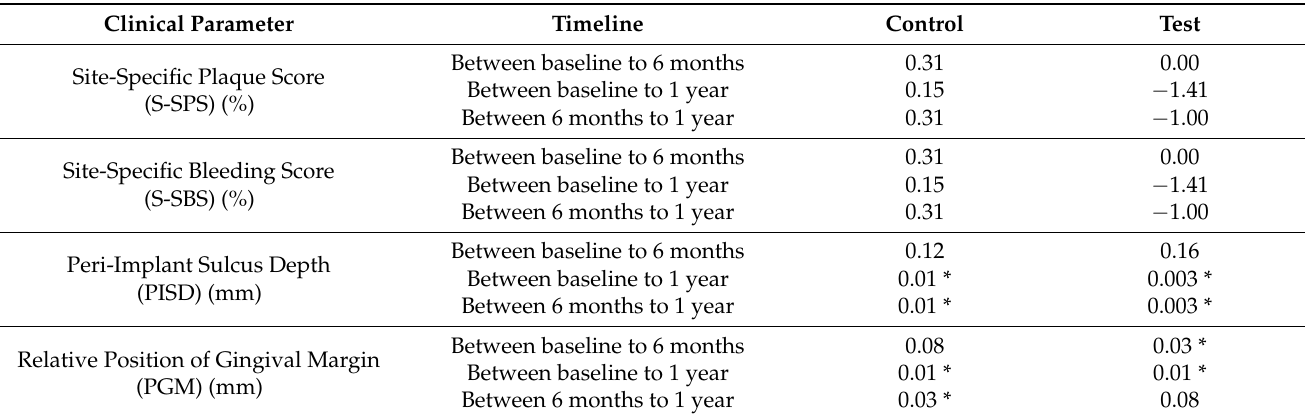
Table 1. Intragroup comparison of clinical parameters between baseline, 6 months, and 1 year in control and test